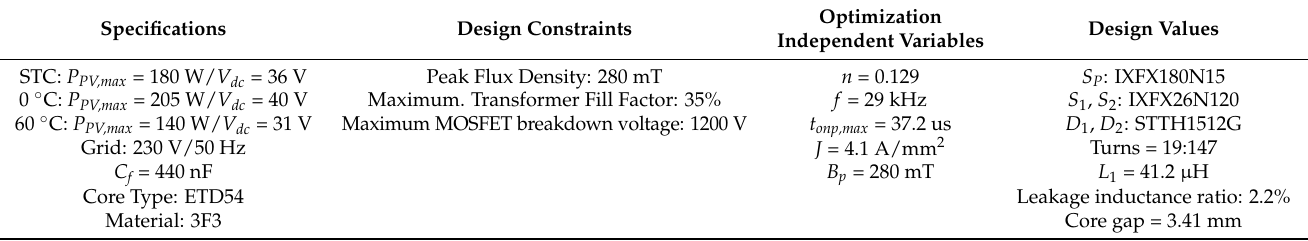
Table 2. Inverter design